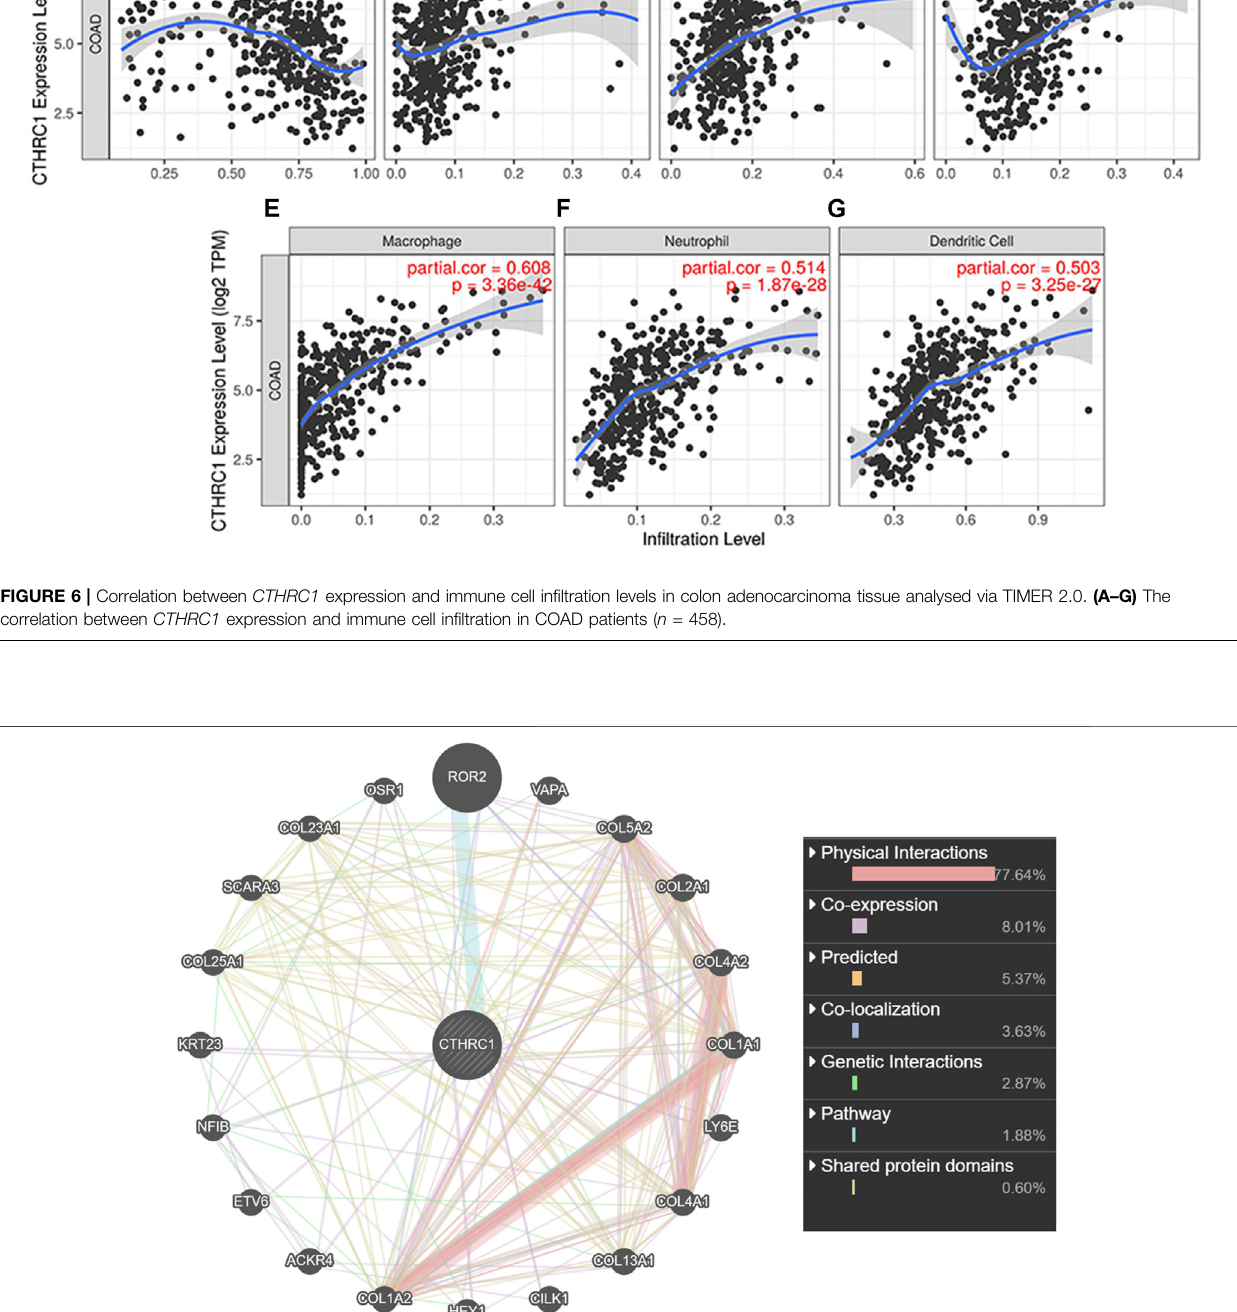
FIGURE 7 | Interaction network analysis of CTHRC1 and its most similar proteins using GeneMANIA.